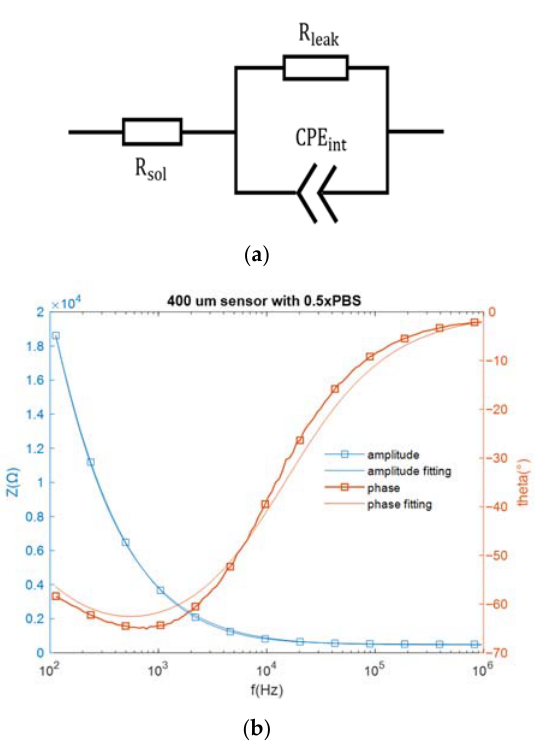
Figure 3. ( a ) The equivalent circuit network for an electrode biosensor, and ( b ) the measured impedance spectra and the fitting spectra.